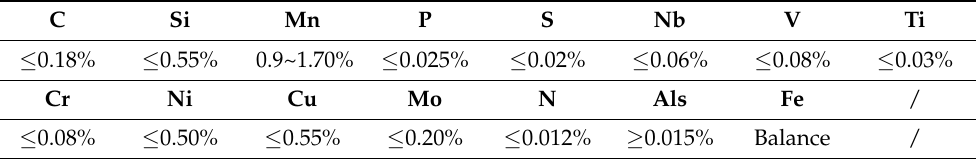
Table 1. Chemical compositions of the low alloy steel (wt